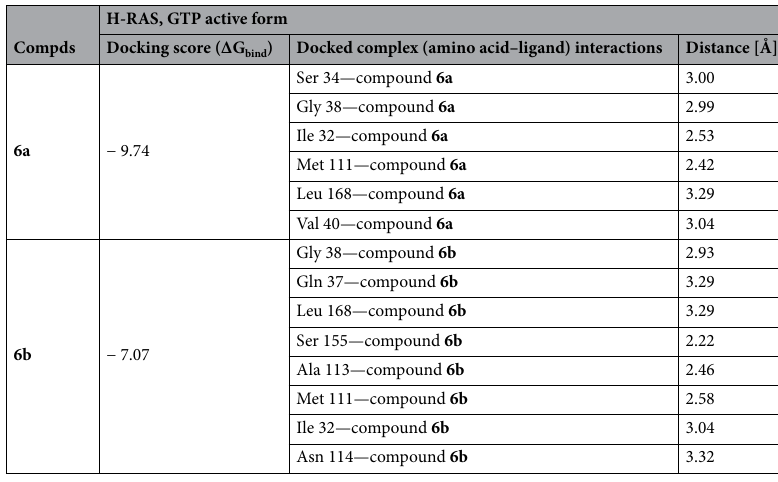
Table 3. Calculated docking scores (in kcal/mol) of the compounds with the target protein.